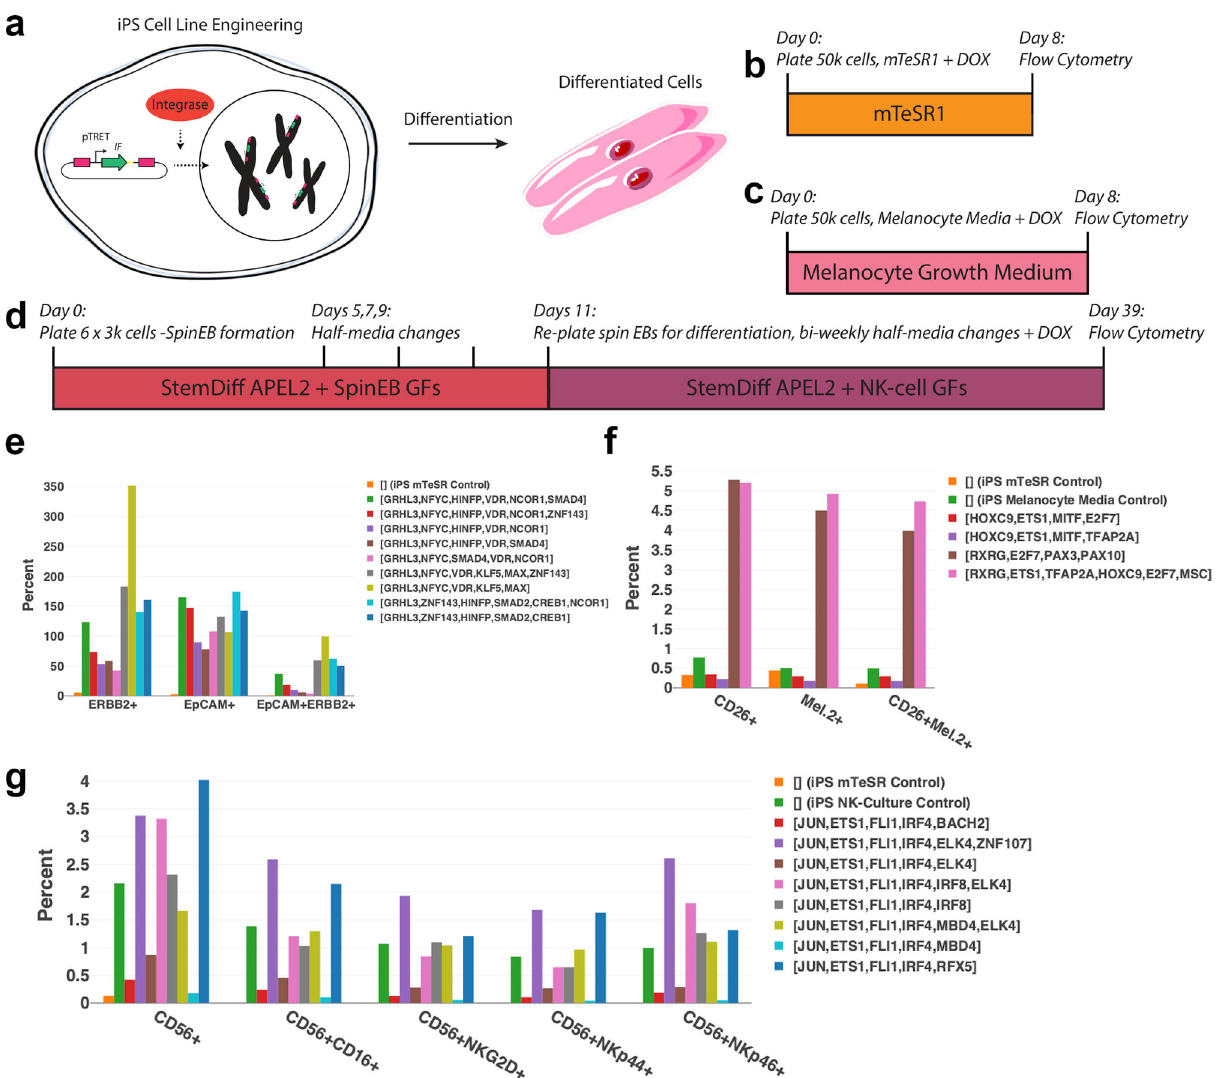
Fig. 3 Experimental validation of improved ef fi ciency of cell type conversion. a Stable iPS lines for all differentiation experiments were created prior to differentiation via genomic integration to ensure high, stable expression of IFs using the human TFome. b Protocol for differentiating human mammary epithelial cells (HMEC) from human iPS cells (hiPSCs). c Protocol for differentiating melanocytes from hiPSCs. d Protocol for differentiating NK cells from hiPSCs. (GF: growth factor, DOX: doxycycline). e – g Differentiation ef fi ciency of ( e ). HMECs, f melanocytes and g NK-cells from hiPSCs for various combinations of IFs generated from IRENE. Ef fi ciency is de fi ned as the number of marker positive/double-positive cells divided by the number of plated cells. n = 1 experiment from three pooled biologically independent